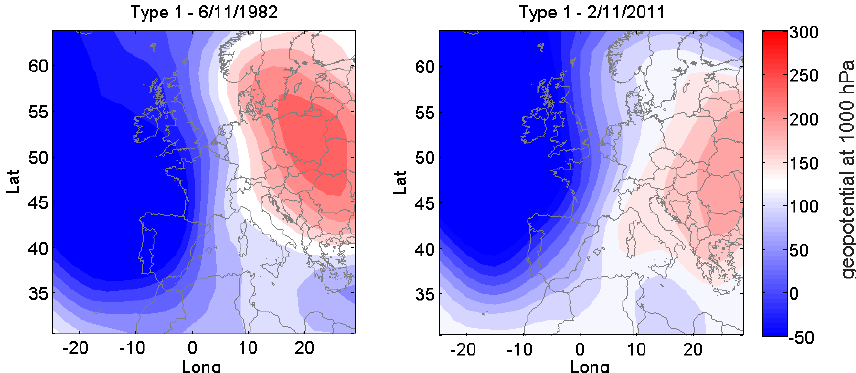
Figure 11. Maps of the 1000hPa geopotential fields of type 1 events extracted at the time closest to the start of the coastal